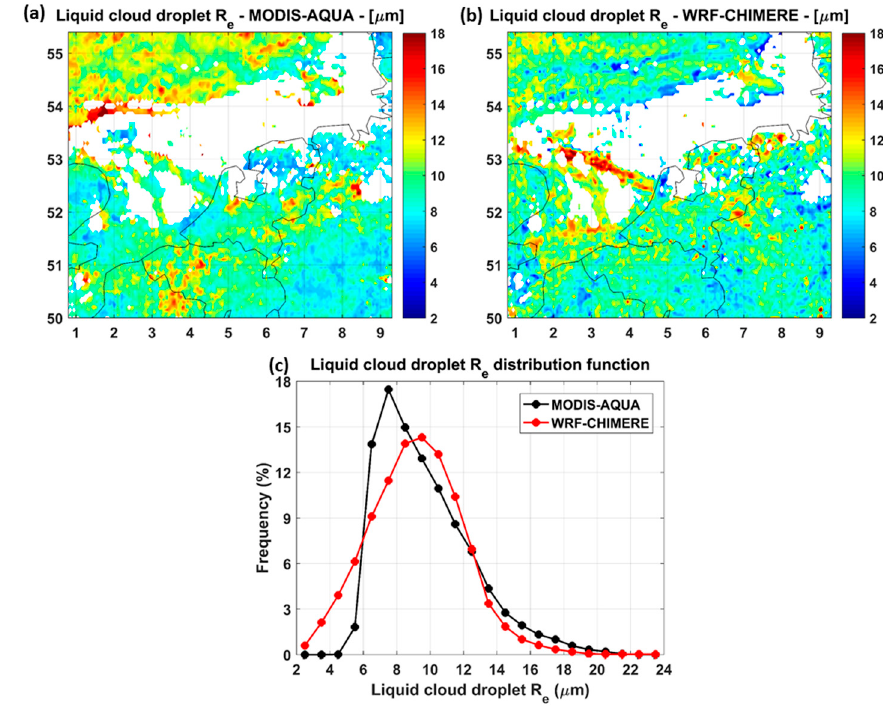
Figure 9. As Figure 8, but cloud droplet effective radius (R e ). Atmosphere 2019 , 10 , x FOR PEER REVIEW